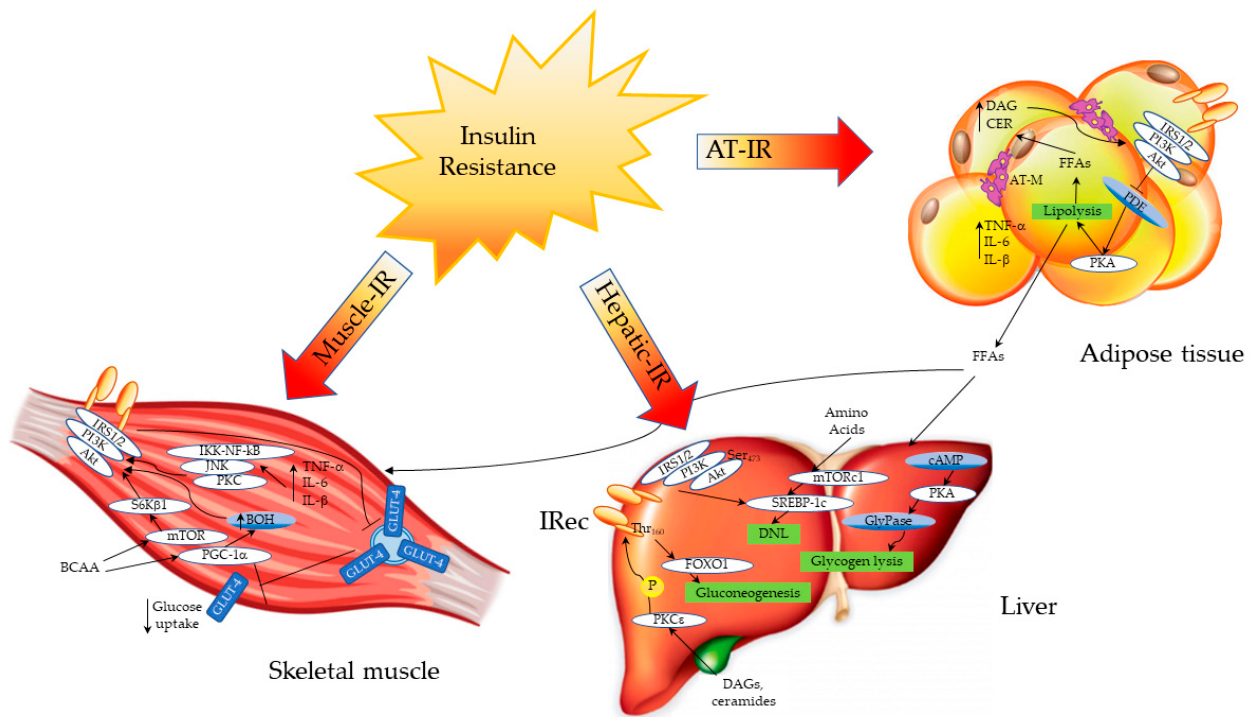
Figure 1. Sites and mechanisms of insulin resistance. Inflamed adipose tissue releases several proinflammatory cytokines such as TNF- α , IL6 and IL-1 β , which inhibit the insulin receptor, impairing insulin signaling. In the insulin-resistant condition, the inadequate suppression of lipolysis (due to the impaired inhibition of PKA) promotes the efflux of free fatty acids (FFAs) from the adipose tissue, which reach the liver and the muscle, where they contribute to ectopic fat accumulation. Abbreviations. Adipose tissue insulin resistance (AT-IR); adipose tissue macrophages (AT-M); protein kinase B (Akt); branched-chain amino acids (BCAA); ceramides (CER); DAGs (diacylglycerols); cyclic adenosine monophosphate (cAMP); de novo lipogenesis (DNL); FFAs (free fatty acids); factor forkhead box 01 (FOXO1); glycogen phosphorylase (GlyPase); glucose transporter type 4 (GLUT4); interleukin 1-beta (IL-1 β ); interleukin 6 (IL-6); insulin receptor (IRec); IRS1/2 (insulin receptor substrate 1/2); protein kinase A (PKA); mammalian target of rapamycin (mTOR); protein kinase C isoform ε (PKC ε ); phosphodiesterase (PDE); peroxisome proliferator-activated receptor gamma co-activator 1 α (PGC-1 α ); phosphatidylinositol 3 kinase (PI3K); ribosomal protein S6 kinase β 1 (S6K β 1); sterol regulatory element-binding protein-1c (SREBP-1c); tumor necrosis factor alpha (TNF- α ).